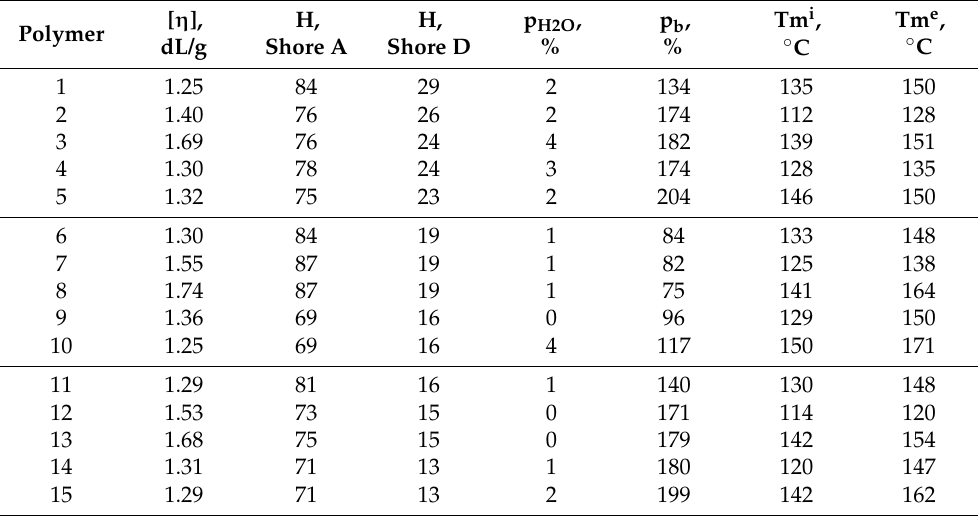
Table 4. The properties of TPE with variable chemical structures of the ester